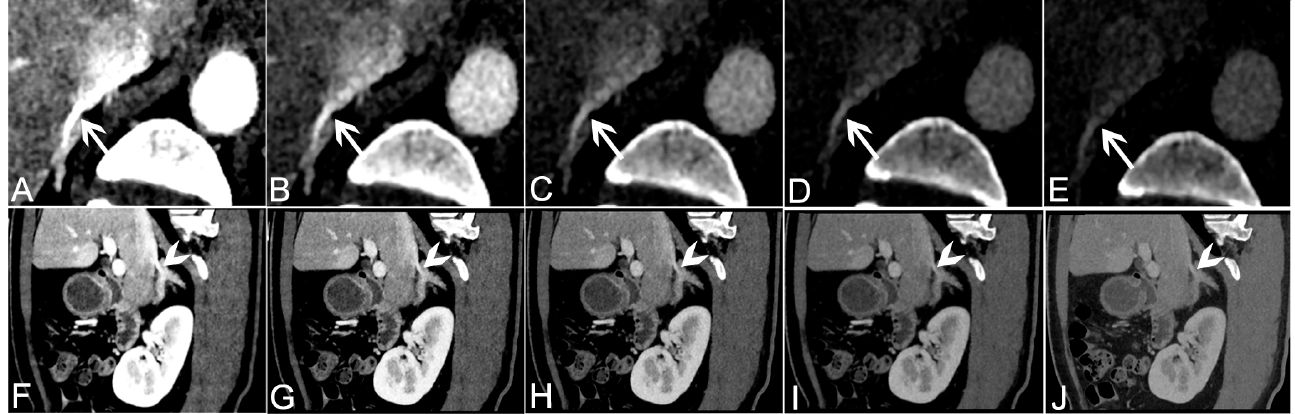
Figure 2. A 61-year-old male patient with a right adrenal adenoma underwent DE-CTA. Axial VMI+ reconstructions at a level of 40 keV ( A ), 50 keV ( B ), 60 keV ( C ), 70 keV ( D ) and 80 keV ( E ). The right adrenal vein (arrows) can be visualized. In this case, the right adrenal vein was filled with the contrast material at 40 keV. The CT value and CNR of the right adrenal vein at 40 keV were higher than those of the 50–80 keV VMI+ reconstructions. Sagittal images were reconstructed to visualize the right adrenal vein (arrowheads): 40 keV ( F ), 50 keV ( G ), 60 keV ( H ), 70 keV ( I ) and 80 keV ( J ). The clarity and observation of solid organs in 50 keV VMI+ reconstructions were better than those in other keV reconstructions. DE-CTA, dual-energy computed tomography angiography; VMI+, advanced virtual monoenergetic images; keV, kiloelectron volt; CNR, contrast-to-noise ratio. The subjective overall image quality scores of solid organs were determined best in the 50 keV VMI+ reconstructions with high interrater agreement, followed by the 40 keV and the 60 keV reconstructions, with significant differences (all p < 0.001). The VMI+ reconstructions at 70 keV and 80 keV received lower scores compared with the 50 keV images (all p < 0.001) (Table